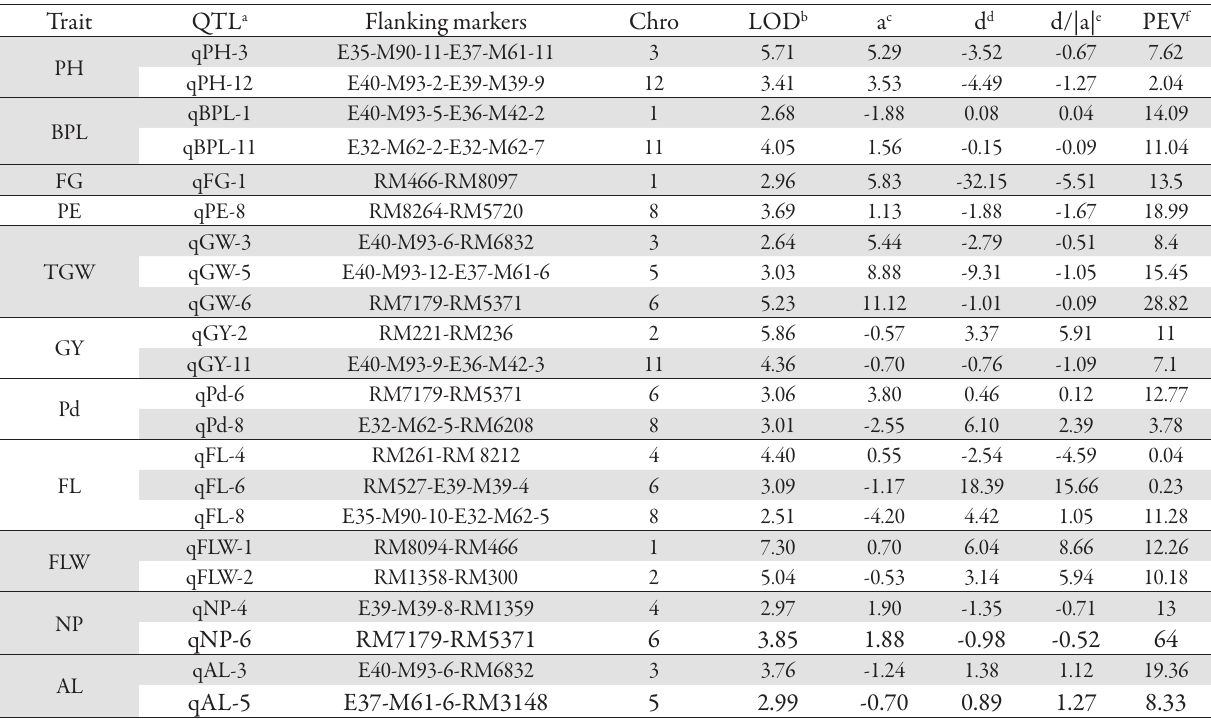
Tab. 4. Putative QTLs for agronomic traits in F